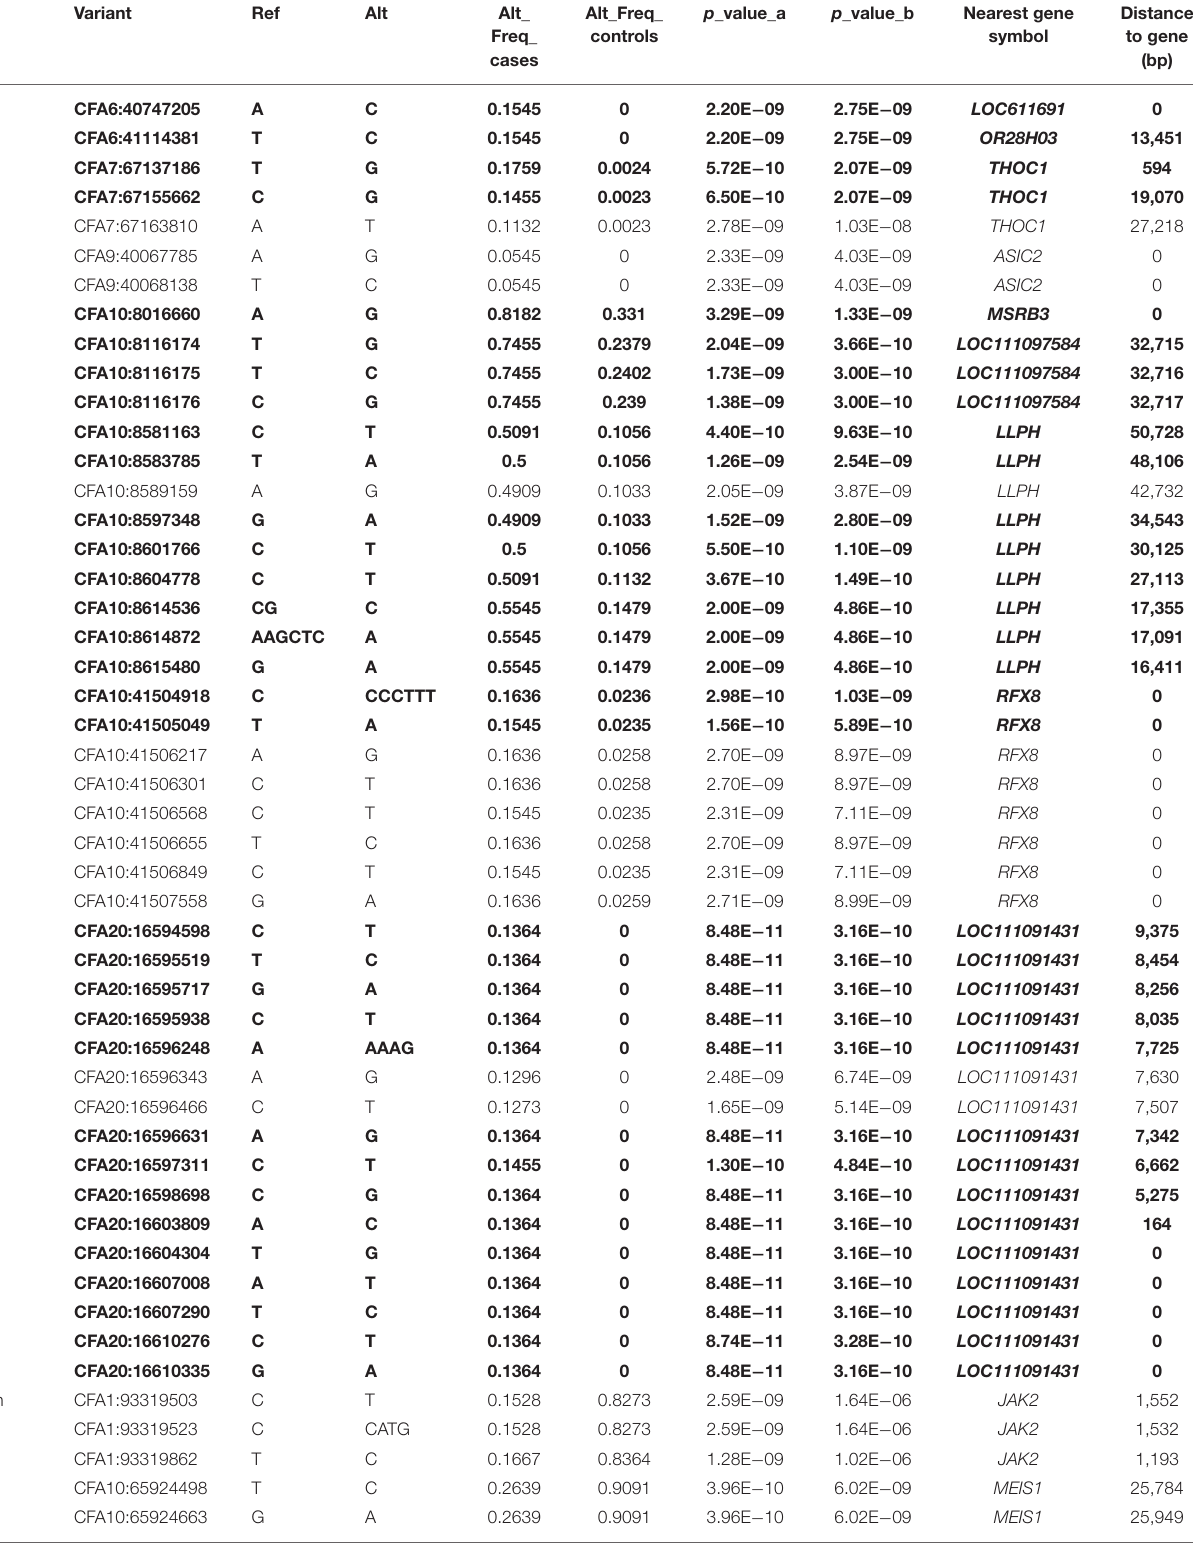
TABLE 2 | Genome-wide association study (GWAS) significant associated variants of dog herding, predation, temperament, and trainability behavior traits. Trait Variant